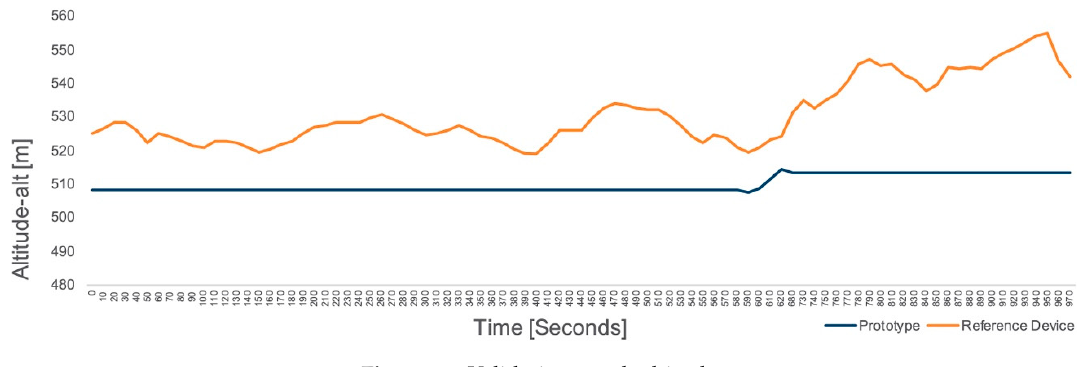
Figure 20. Validation graph altitude.